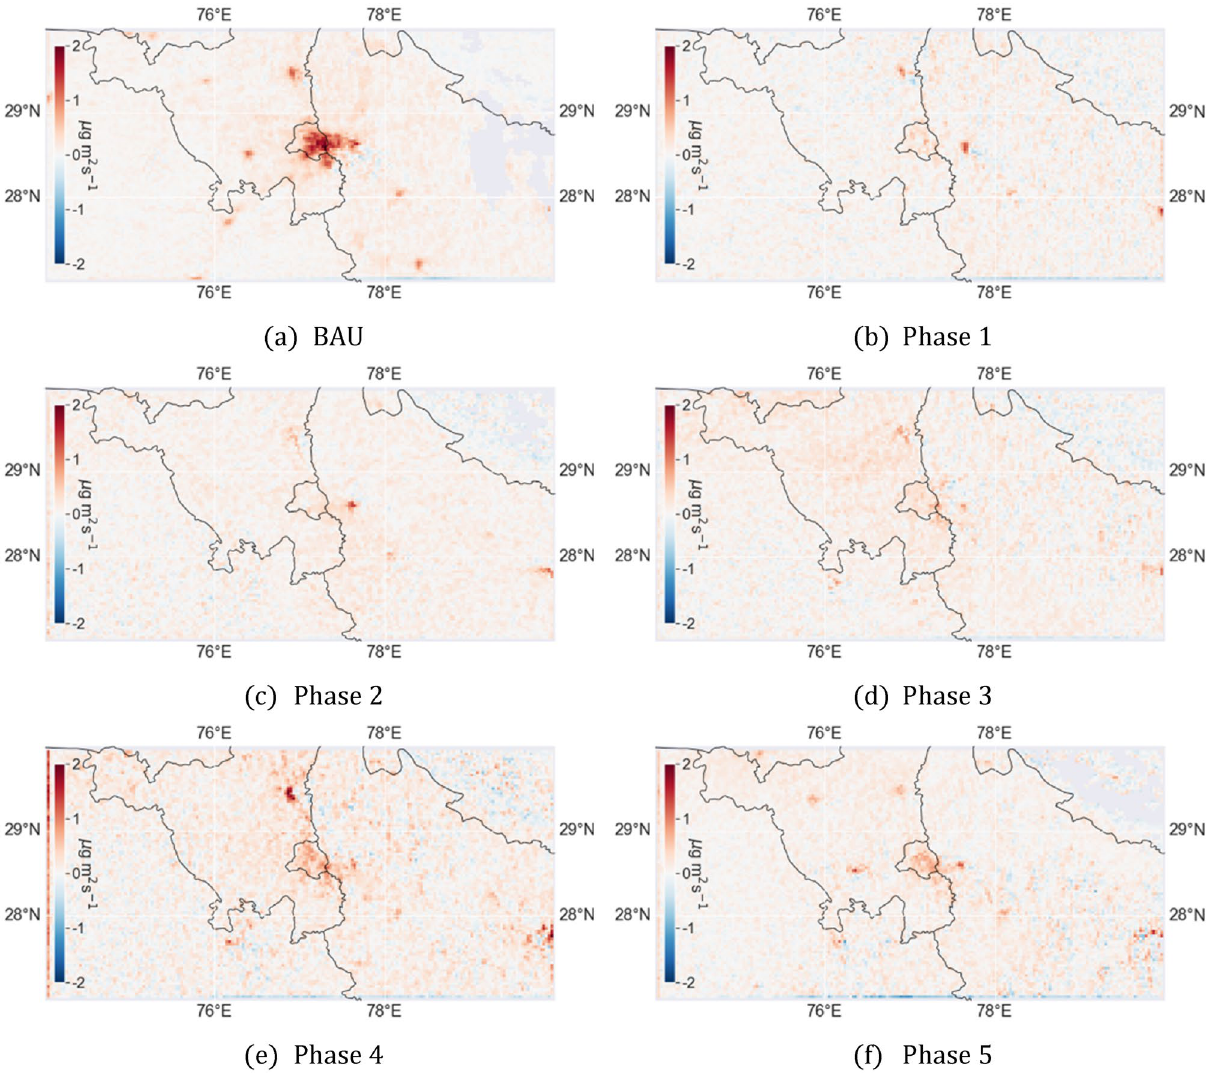
Figure 3. Mean top-down NOx emission in 2020 during ( a ) BAU (business-as-usual), and subsequent lockdown-phases ( b – f ). Figures generated using ‘Cartopy’ version 0.16 and ‘Rasterio’ version 1.2 modules of Python 3.6.